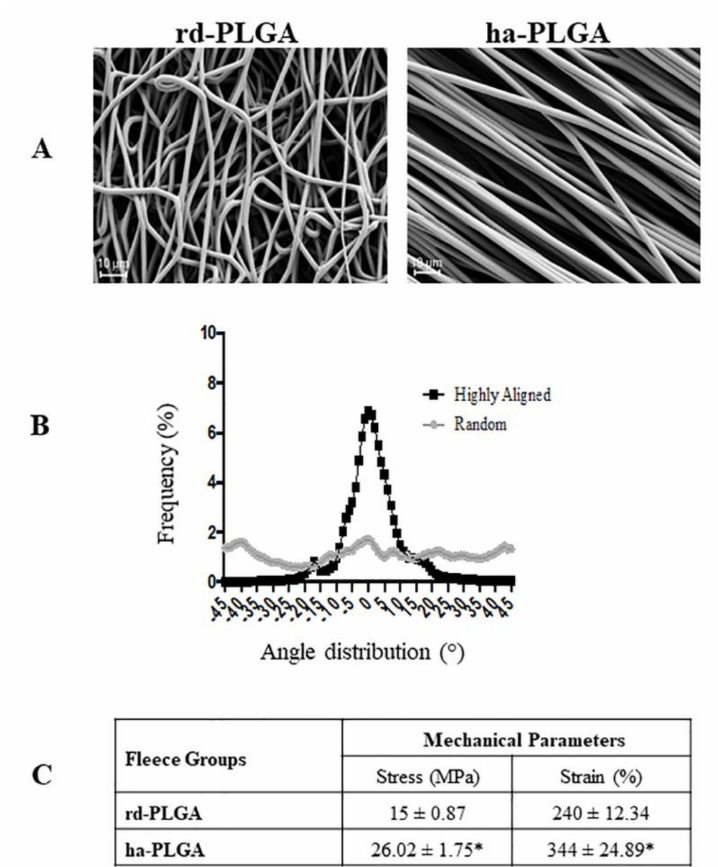
Figure 1. Structural and mechanical characteristics of electrospun poly(lactide-co-glycolide) (PLGA) microfibers. ( A ) SEM micrographs of the electrospun PLGA random-oriented (rd-PLGA) and highly aligned (ha-PLGA) fibers showing defect free fleeces (n = 3 for each type of fleece). Scale bars = 10 µ m. ( B ) Frequency distribution of fiber orientation within PLGA fleeces with randomly distributed or highly aligned fibers. By increasing the rotational speed of the rotator collector, fibers become parallel, showing a sharp Gaussian curve where their orientation is mainly ranging within an angle from − 10 ◦ to + 10 ◦ differently to that of the fibers with random distribution with angles ranging from − 45 ◦ to + 45; (n = 3 for each type of fleece). ( C ) Mechanical tests: stress (MPa) and strain (%) carried out on rd-PLGA and ha-PLGA fleeces (n = 5 for each type of fleece, scaffold dimension: 50 mm × 15 mm). Electrospun ha-PLGA fleeces possess higher mechanical properties compared to those for rd-PLGA. * Statistically significant values between rd-PLGA and ha-PLGA fleeces ( p <